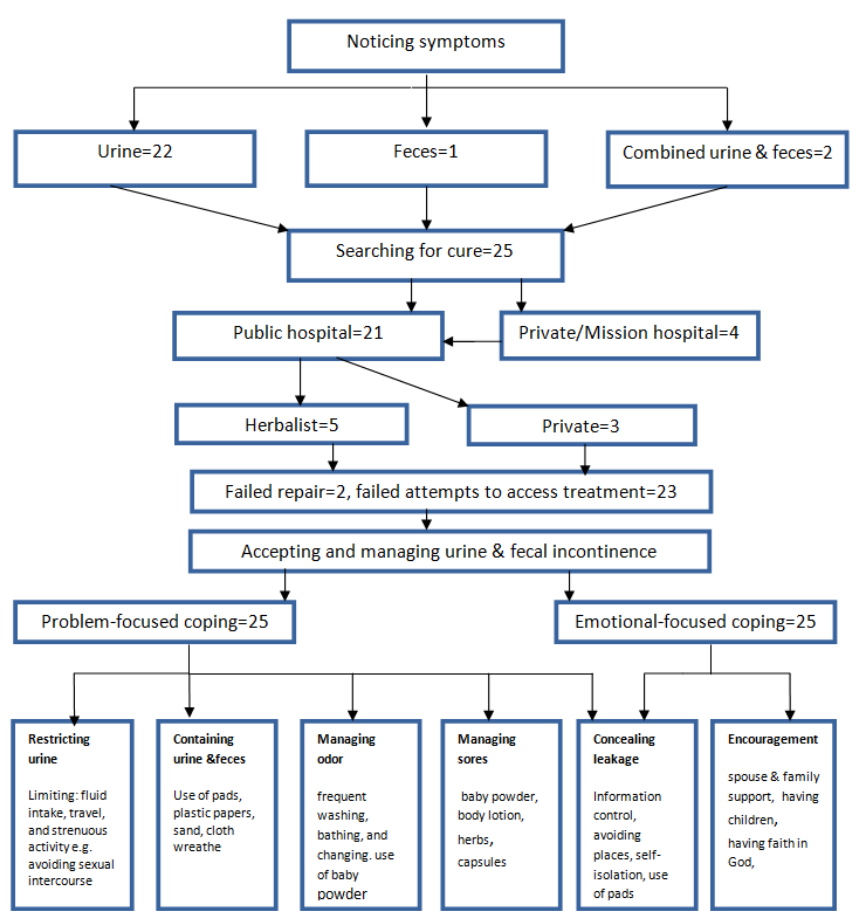
Figure 1. Obstetric fistula pathway delineated for the 25 study participants based on their testimonies.